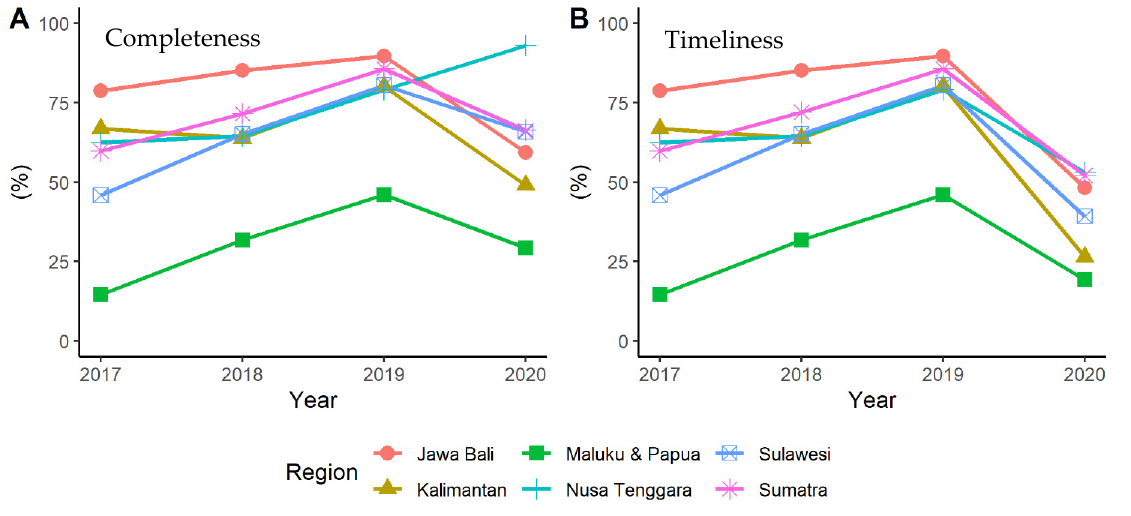
Figure 3. Percentage trends of ( A ) Completeness and ( B ) Timeliness from each region between 2017–2020.